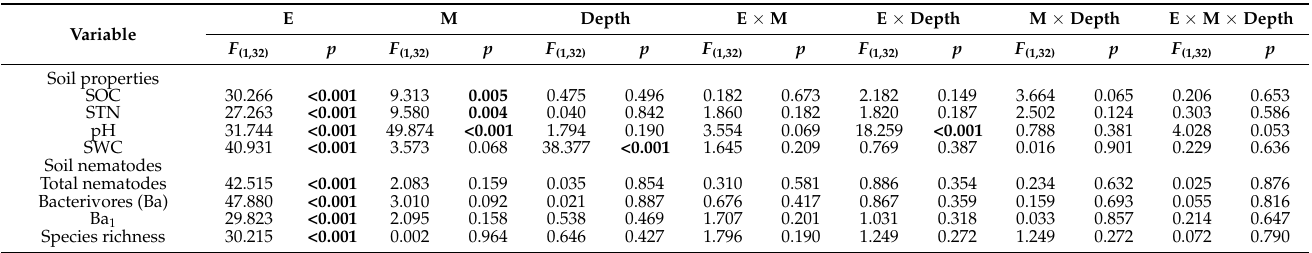
Table 1. Effects of earthworm addition (E), millipede addition (M), and soil depth (depth) on soil properties, soil nematode abundance, and diversity.